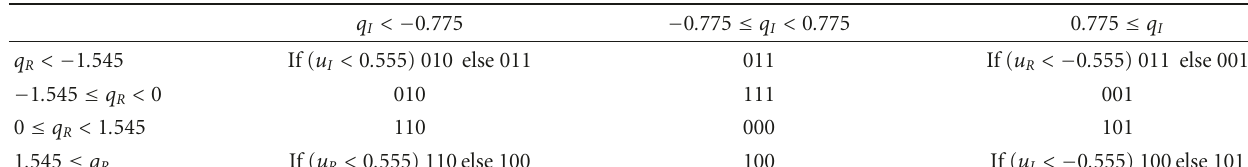
Table 1: LUT for ML detection of the three transmitters scenario.